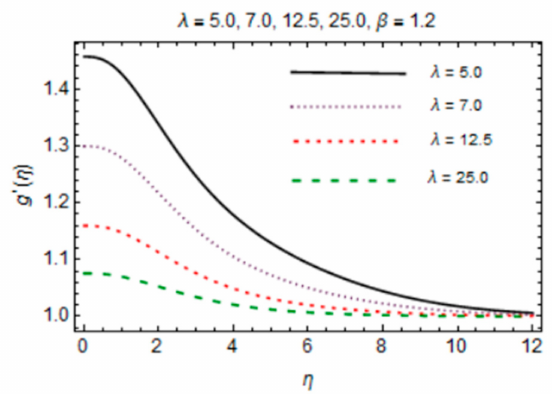
Figure 10. λ verses induced magnetic field profile.